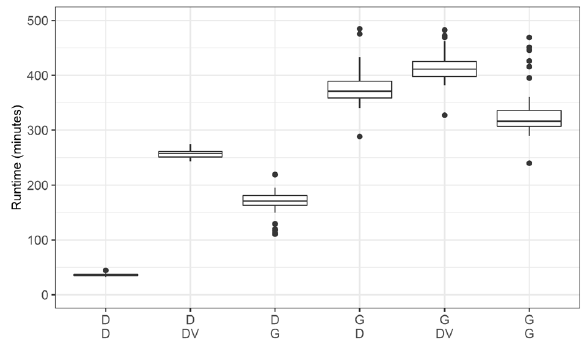
Figure 2. Runtime comparison of the 6 pipelines. The first row in the legend on the x-axis displays the approach used for mapping and alignment. The second row in the legend on the x-axis displays the variant caller used. In detail: D/D: DRAGEN for mapping and alignment and variant calling. D/DV: DRAGEN for mapping and alignment, DeepVariant for variant calling. D/G: DRAGEN for mapping and alignment, GATK with Haplotypecaller not in the DRAGEN mode for variant calling. G/D: GATK for mapping and alignment, GATK with Haplotypecaller in the DRAGEN mode for variant calling. G/DV: GATK for mapping and alignment, DeepVariant for variant calling. G/G: GATK for mapping and alignment, GATK without Haplotypecaller in the DRAGEN mode for variant calling.